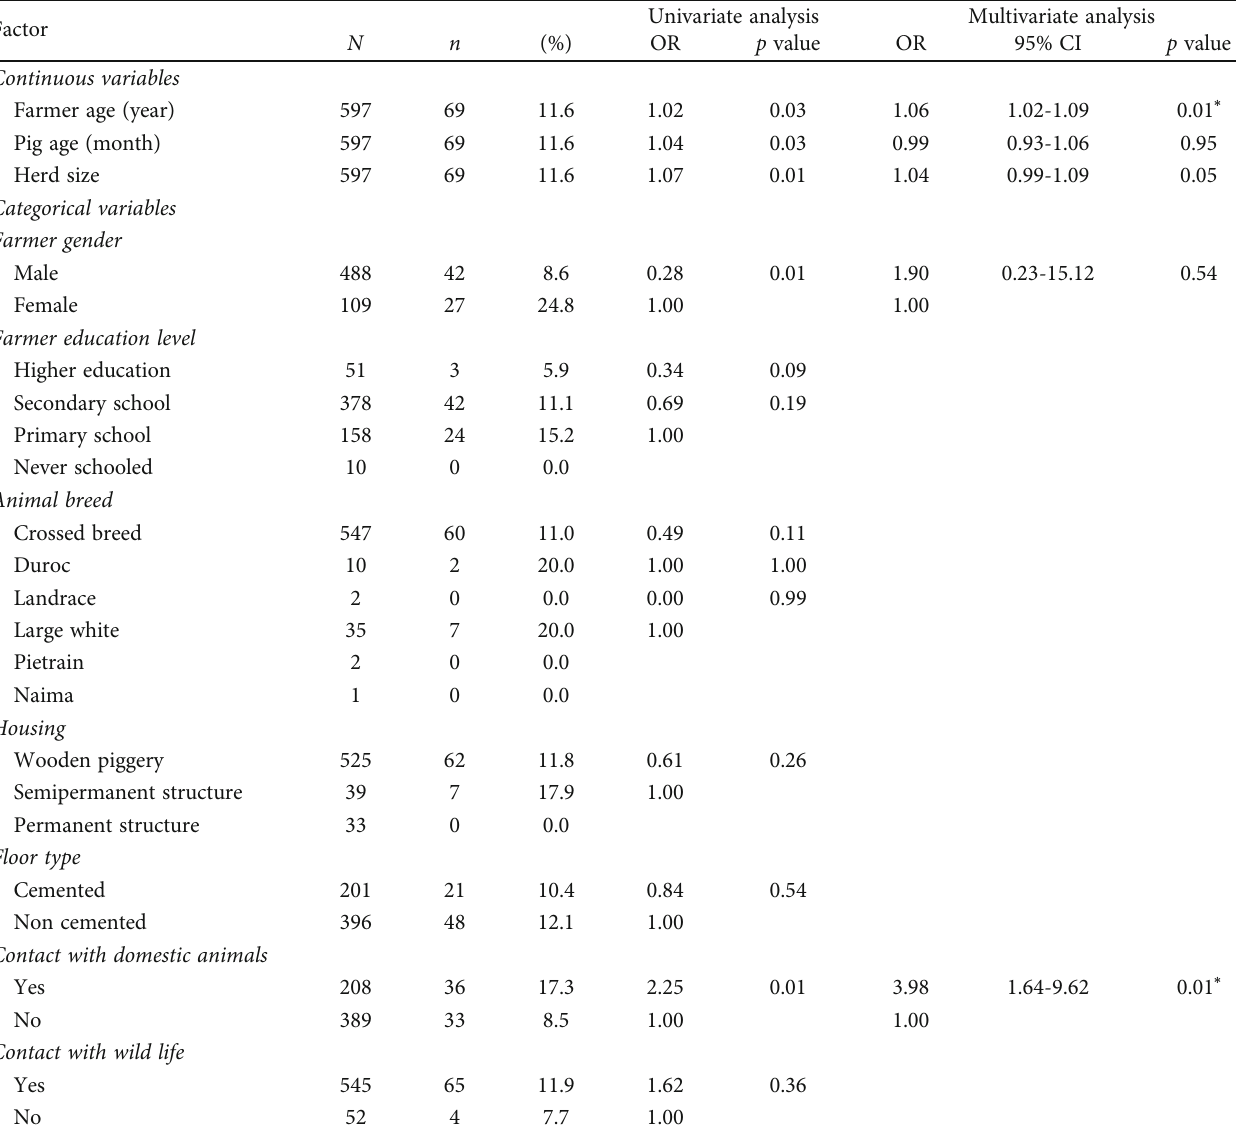
Table 6: Logistic regression analysis of risk factors for Ascaris suum infection in pig farms in Menoua Division. Results are expressed in terms of odd ratio (OR) and 95% con fi dence interval